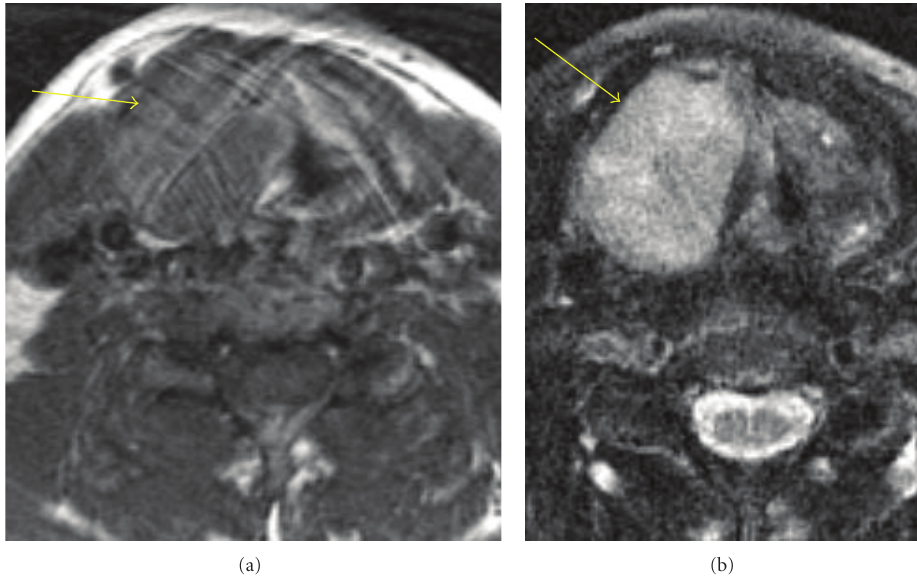
Figure 1: Axial T1 (a) and T2 (b), noncontrast: homogeneous, well-defined mass of the right thyroid cartilage laminae.